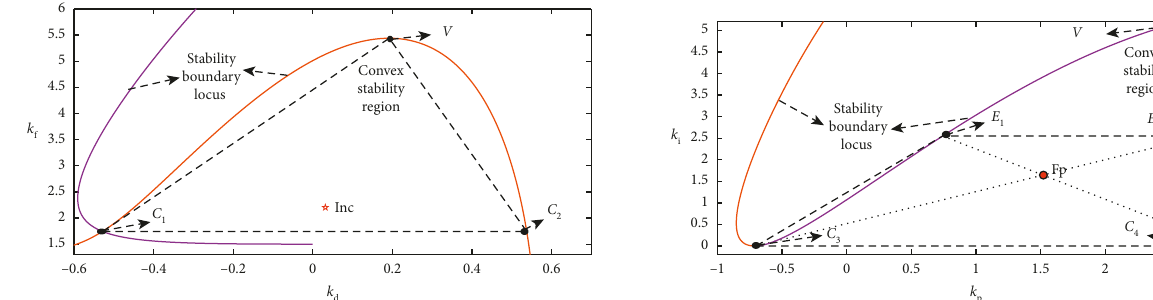
Figure 11: Common convex stable region and Fermat point of the PI controller in example C.